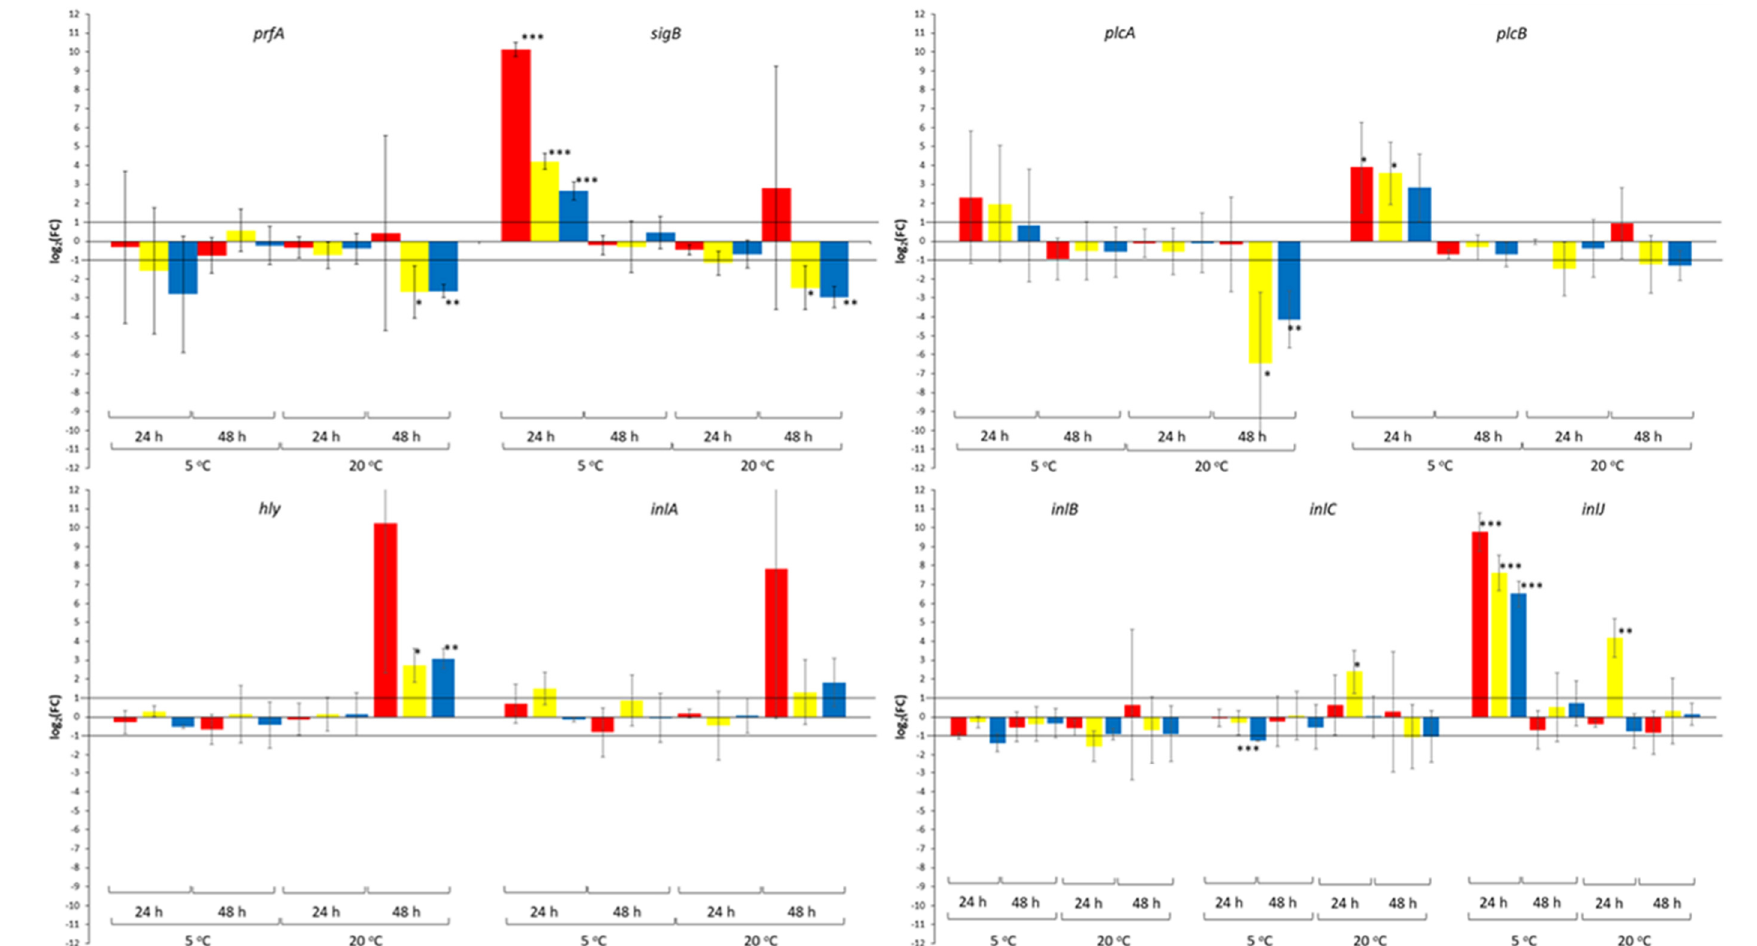
Figure 1. Effect of co-culture with S. cerevisiae strains Y32 (red bars), Y34 (yellow bars) and Y37 (blue bars) on the relative transcription of prfA , sigB , hly , plcA , plcB , inlA , inlB , inlC and inlJ , during growth of L. monocytogenes strain LQC 15257 in BHI broth at 5 and 20 °C for 24 and 48 h. Growth of the pathogen in monoculture was used as control. Error bars represent the standard deviation of the mean value. Presence of asterisks indicates that the relative transcription was above 1 or below − 1 (the values that were used as threshold) at p value indicated by the number of asterisks (* p < 0.05; ** p < 0.01; *** p < 0.001).